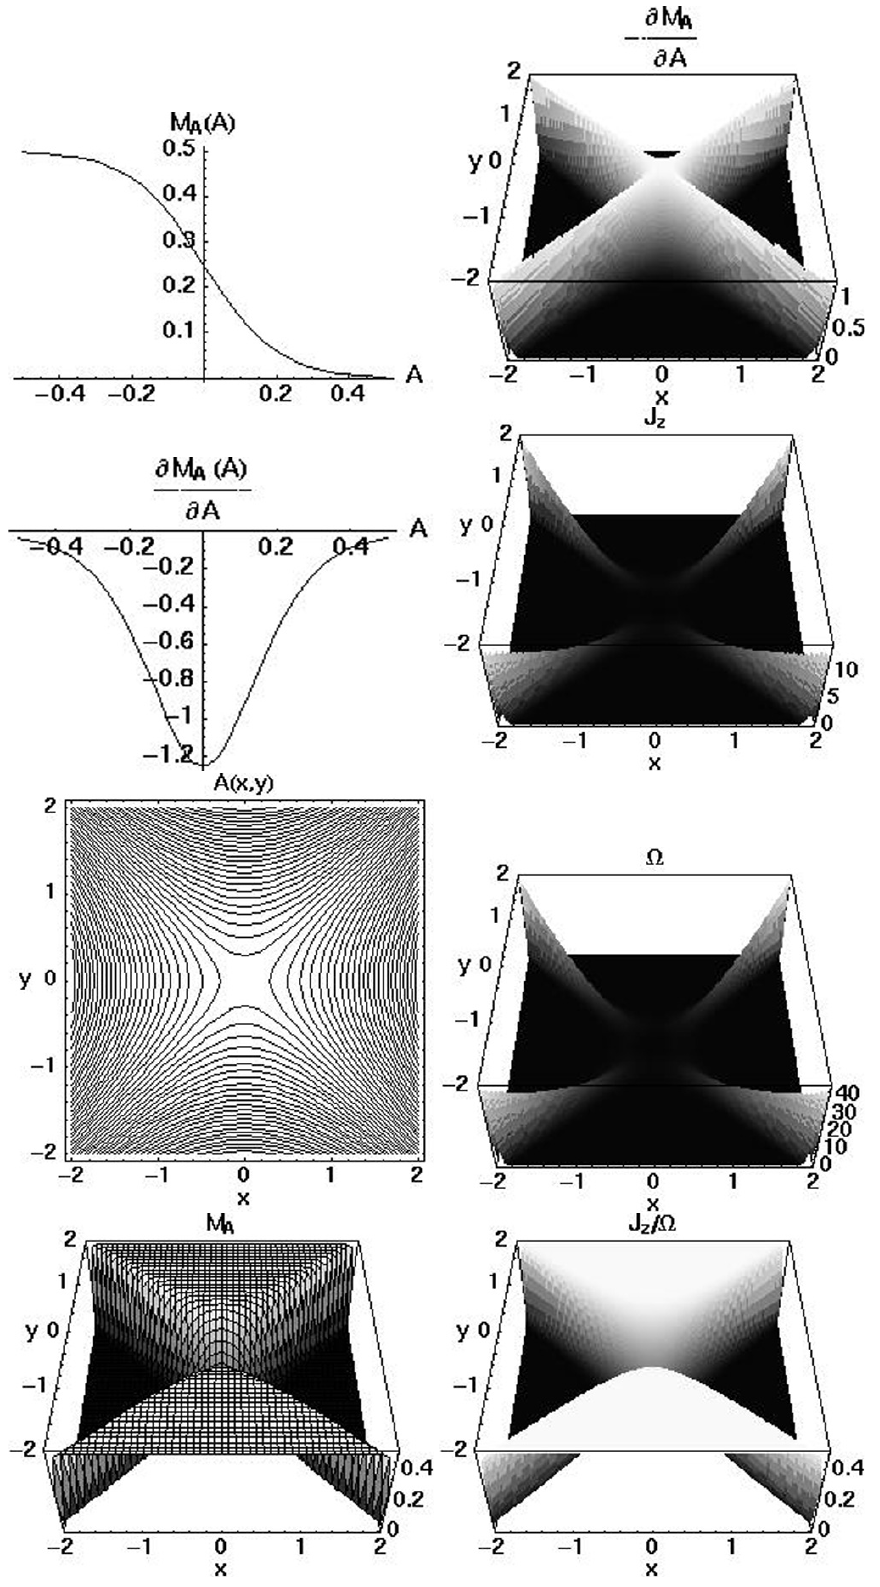
Fig. 1. Transformation from an initial potential field with a smooth Mach-number profile (see Eq. 37 with M Amax = 0 . 5 and d = 0 .